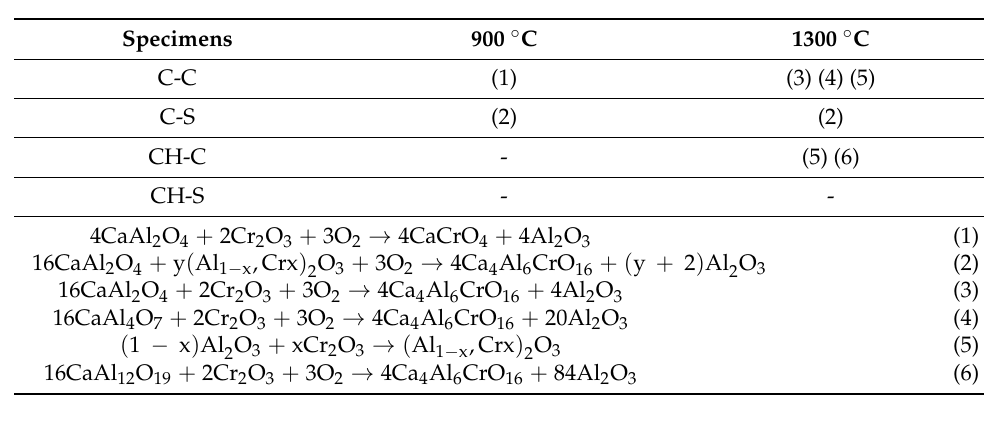
Table 5. Chemical reaction equations in cylindrical